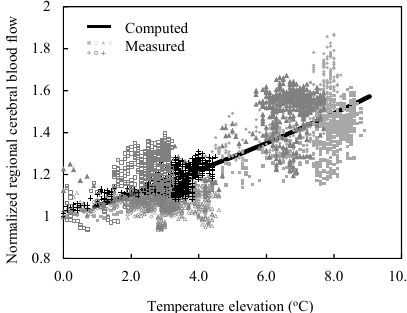
Figure 3. Regional cerebral blood flow and regional temperatures in the target area of the rat brain during localized MW exposure at 10 GHz. The solid line shows the values calculated based on Equation (7). The markers show the experimental values ( n = 7, depicted by the markers) including the SARs averaged over the brain that correspond to 29 and 79 W · kg − 1